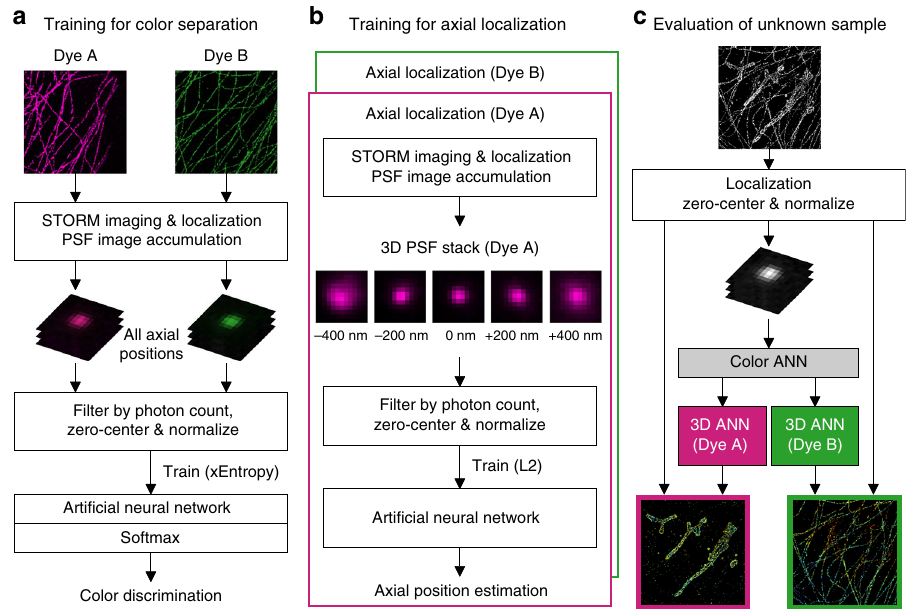
Fig. 1 Work fl ow of the machine learning-based multidimensional SMLM. a A color-separating ANN is trained using samples each singly labeled by one known fl uorophore, in which PSFs at different axial positions are well-represented. b ANNs for resolving the axial position are separately trained for each fl uorophore using PSFs of known axial positions. c For the analysis of unknown samples, single-molecule images are localized in 2D, and fi rst fed into the color-separating ANN described in a . The color-separated single-molecule images are then separately fed into the axial-localization ANNs trained with the corresponding fl uorophores, as described in b . The resultant color and axial position information are then combined with the 2D localization of each molecule to generate the fi nal multidimensional SMLM